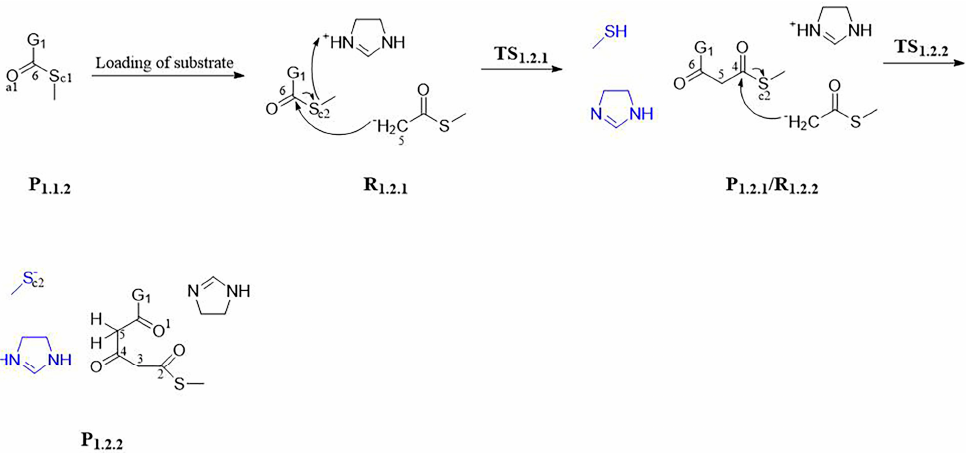
Scheme 4. The reaction process and predicted reaction mechanism of Step 1.2 of Stage 1. Blue molecules represent product molecules not involved in the next reaction. Group G 1 is shown in Scheme 1.